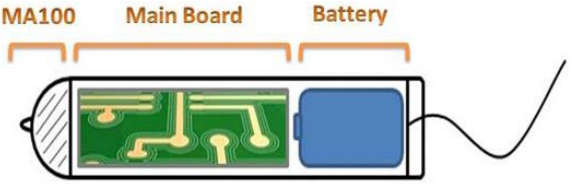
Figure 1. Conceptual design of the new intra-vaginal temperature monitoring sensor mote.